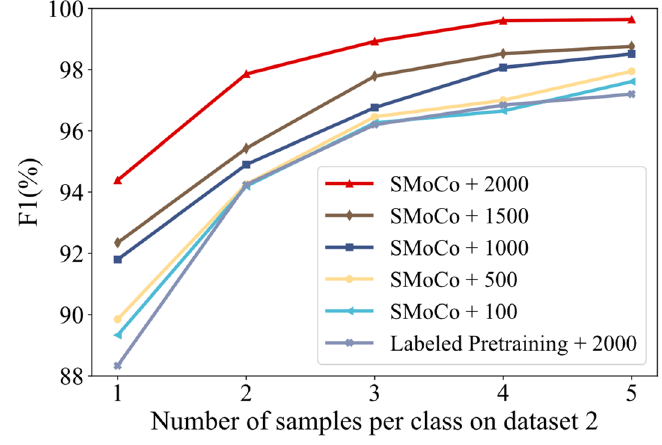
Figure 17. Experimental results of the sensitivity to the size of the data set on dataset 2. Table 9. Experimental results of the sensitivity to the size of the data set on dataset 3.